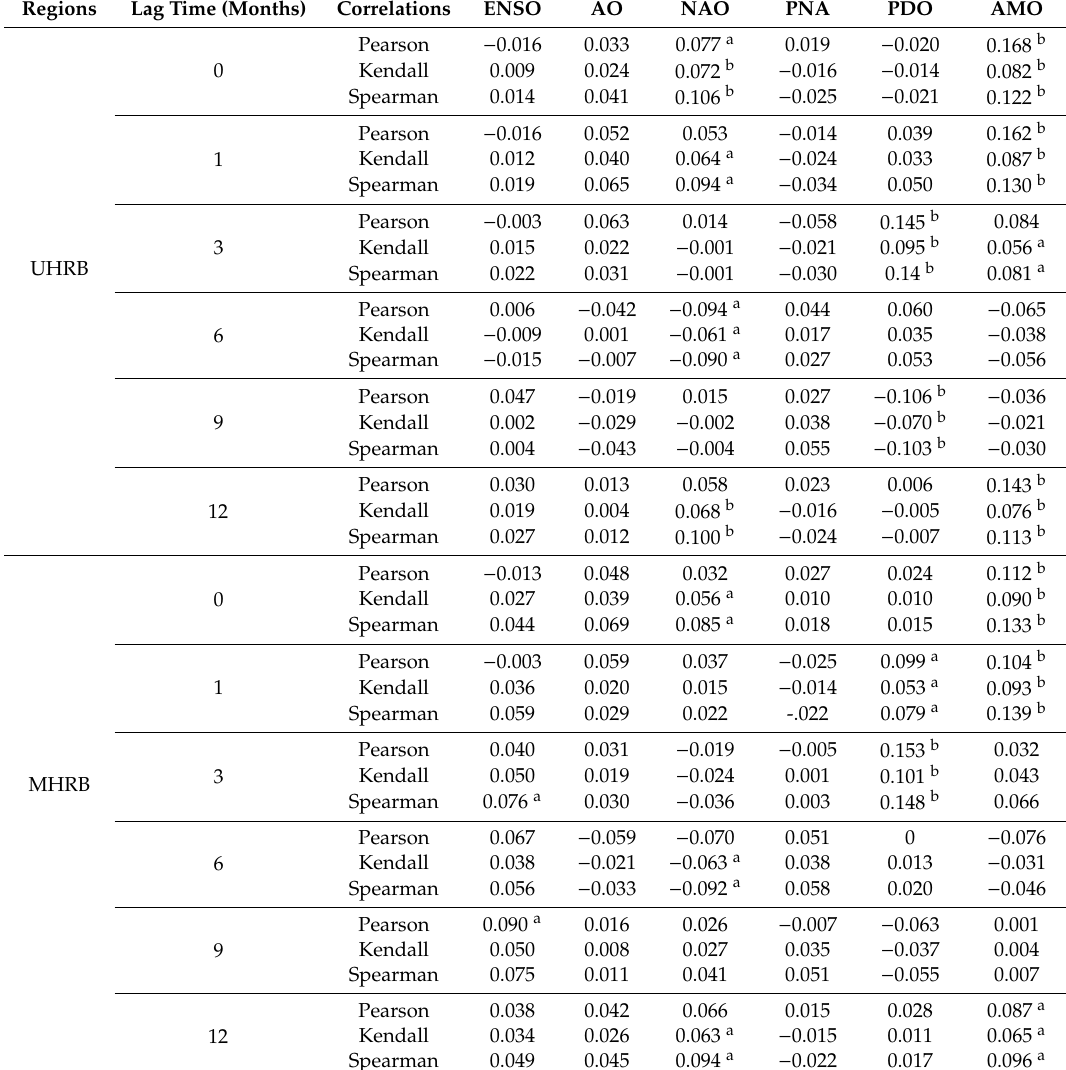
Table 4. Correlations between the large-scale climate indices and lag-time coe ffi cients of precipitation in the upper (UHRB) and middle (MHRB) reaches of the Heihe River Basin.